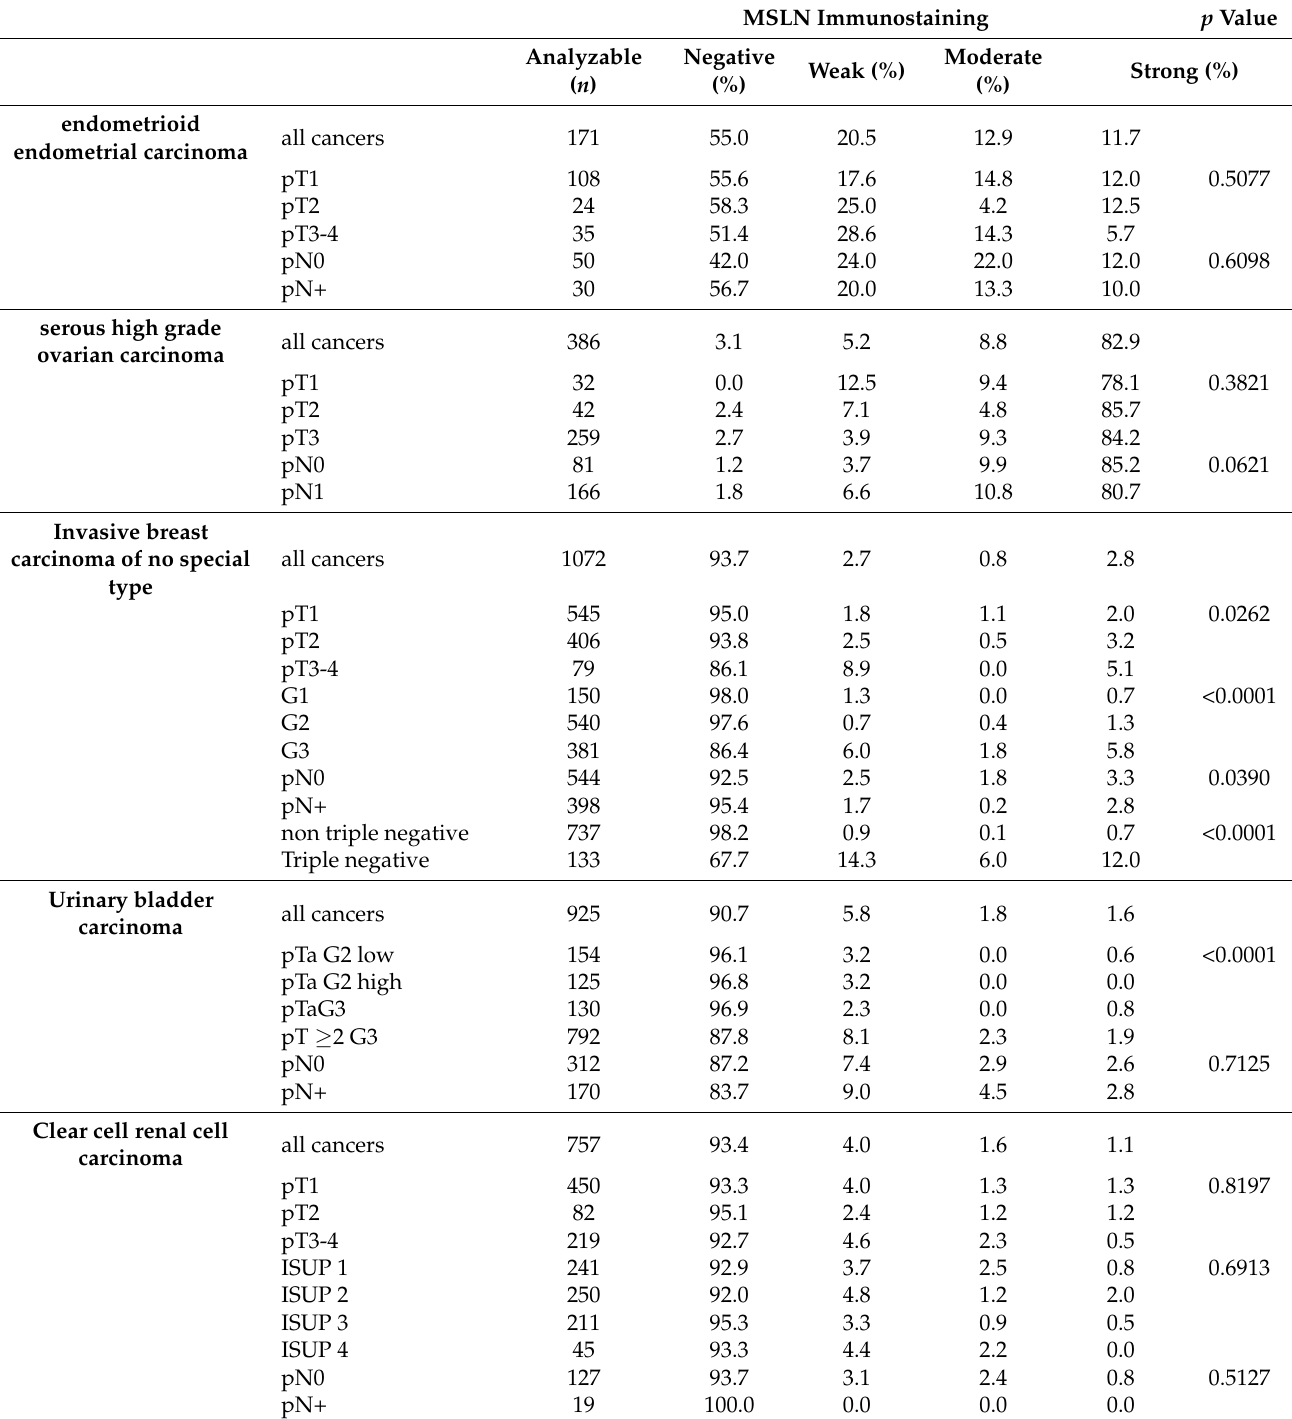
Table 2. MSLN immunostaining and tumor